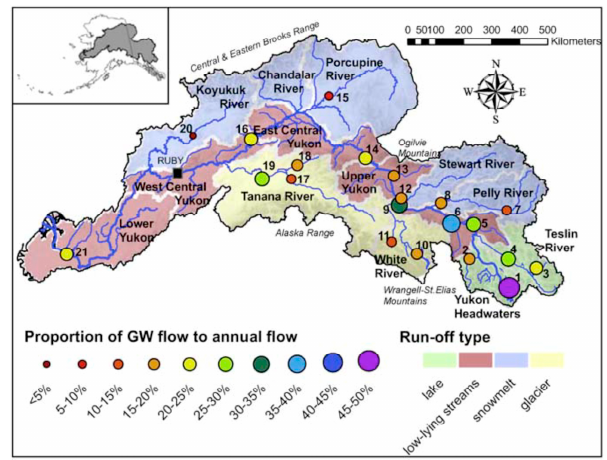
Figure 3. Calculated contributions of groundwater to river flow in the Yukon River watershed from Walvoord and Striegl [2]. Reprinted with permission.